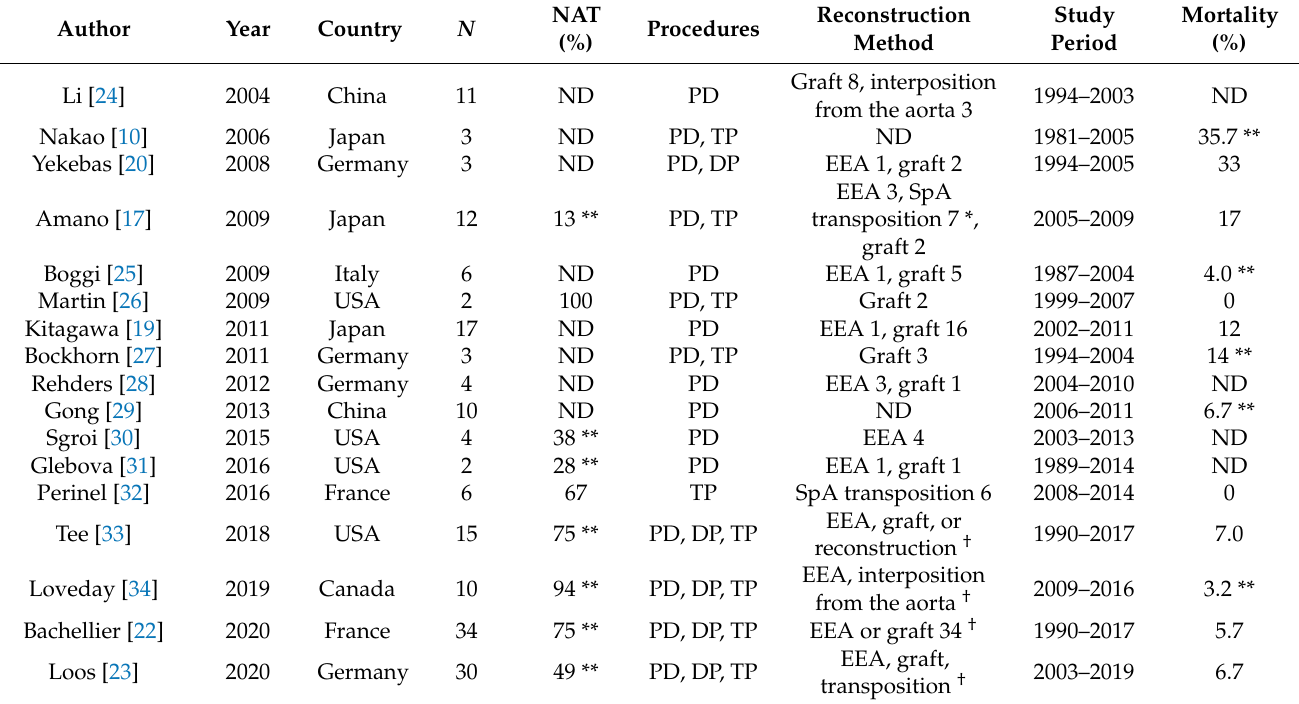
Table 1. Previous reports about resection of the superior mesenteric